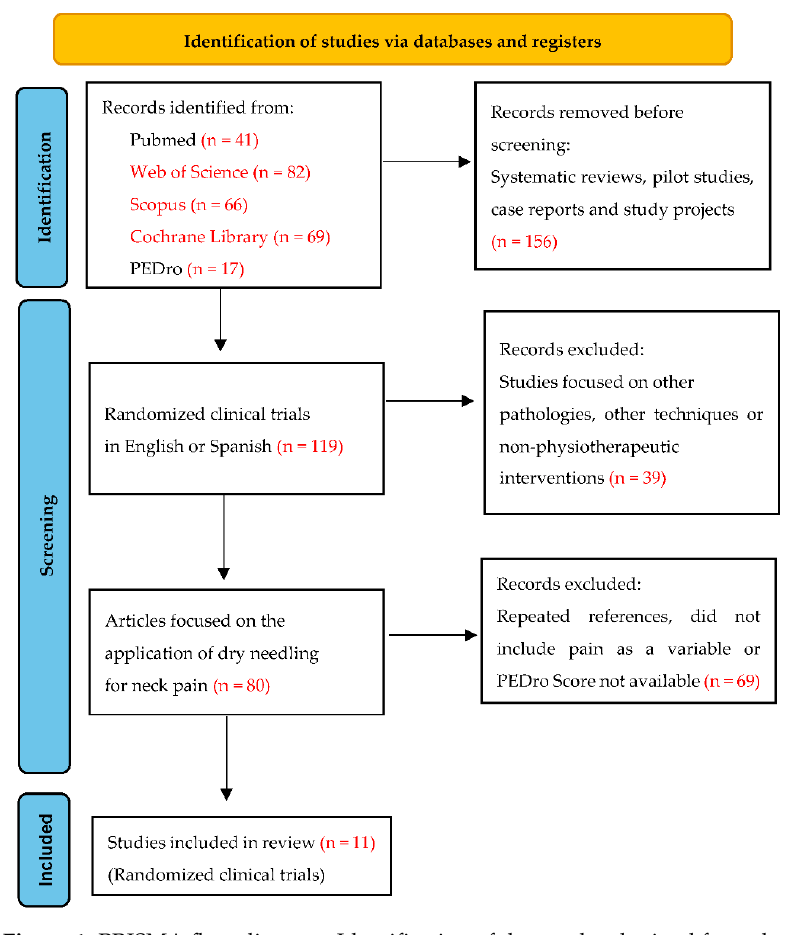
Figure 1. PRISMA flow diagram. Identification of the results obtained from the databases.